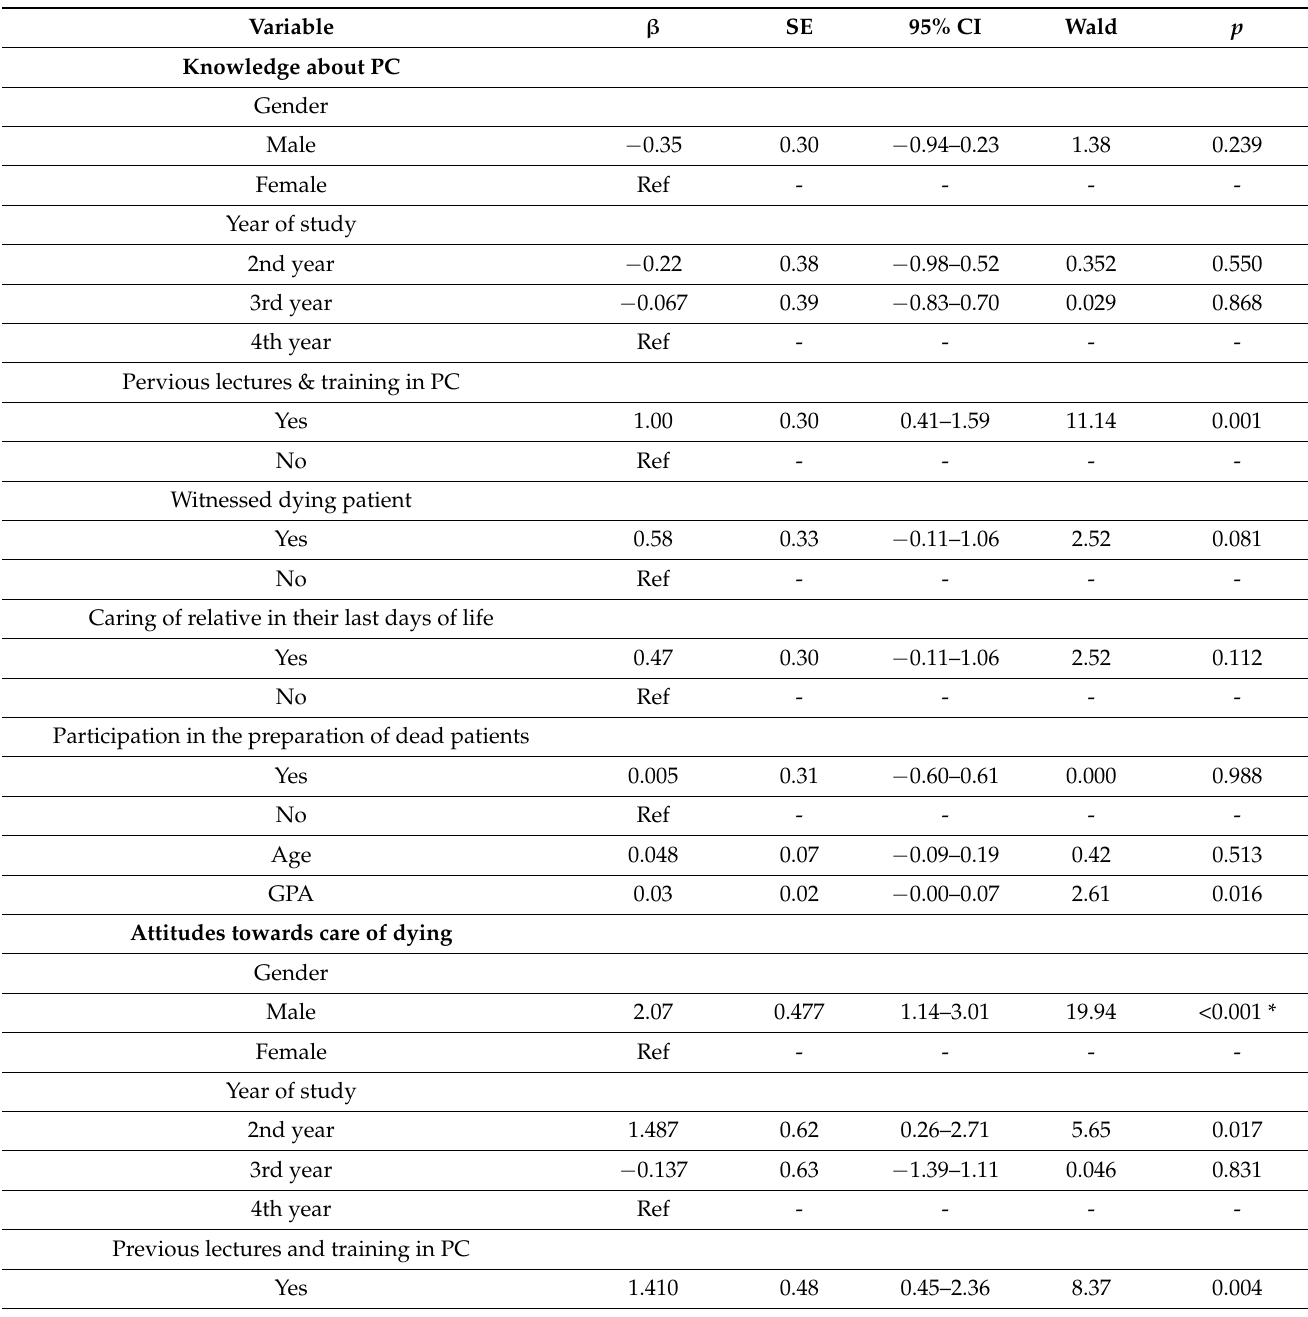
Table 4. Generalized linear regression model for factors associated with students’ knowledge about palliative care and attitudes toward care of